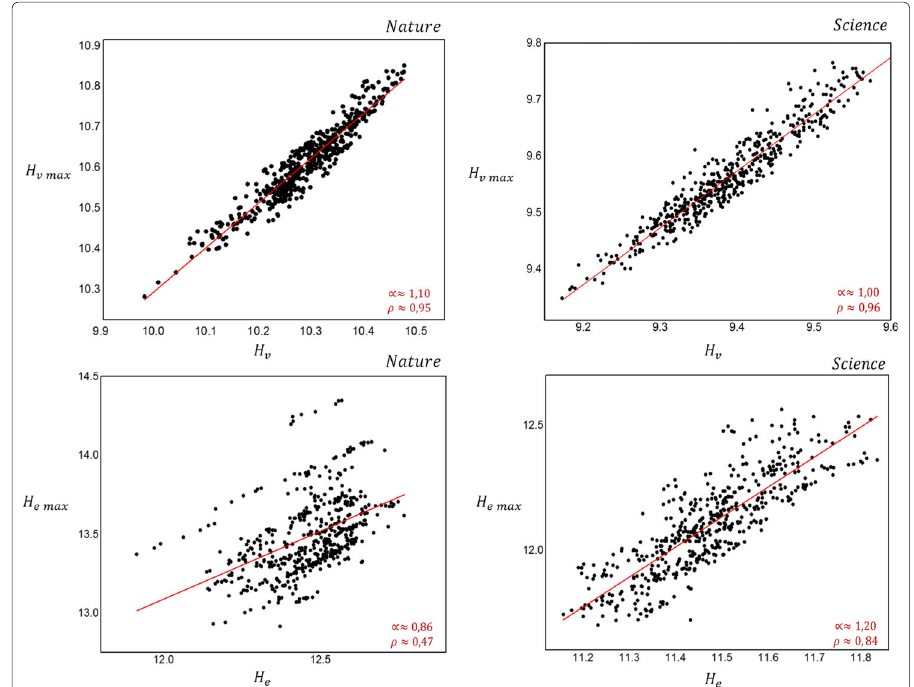
Fig. 7 Maximum entropy values, as a function of the real values H v and H e for the journals Nature and Science. The line shows the linear adjustment for the points and shows the difference between the correlation of the vertex entropies and that of the edge entropies, α is the linear fit coefficient and ρ is Pearson’s correlation coefficient